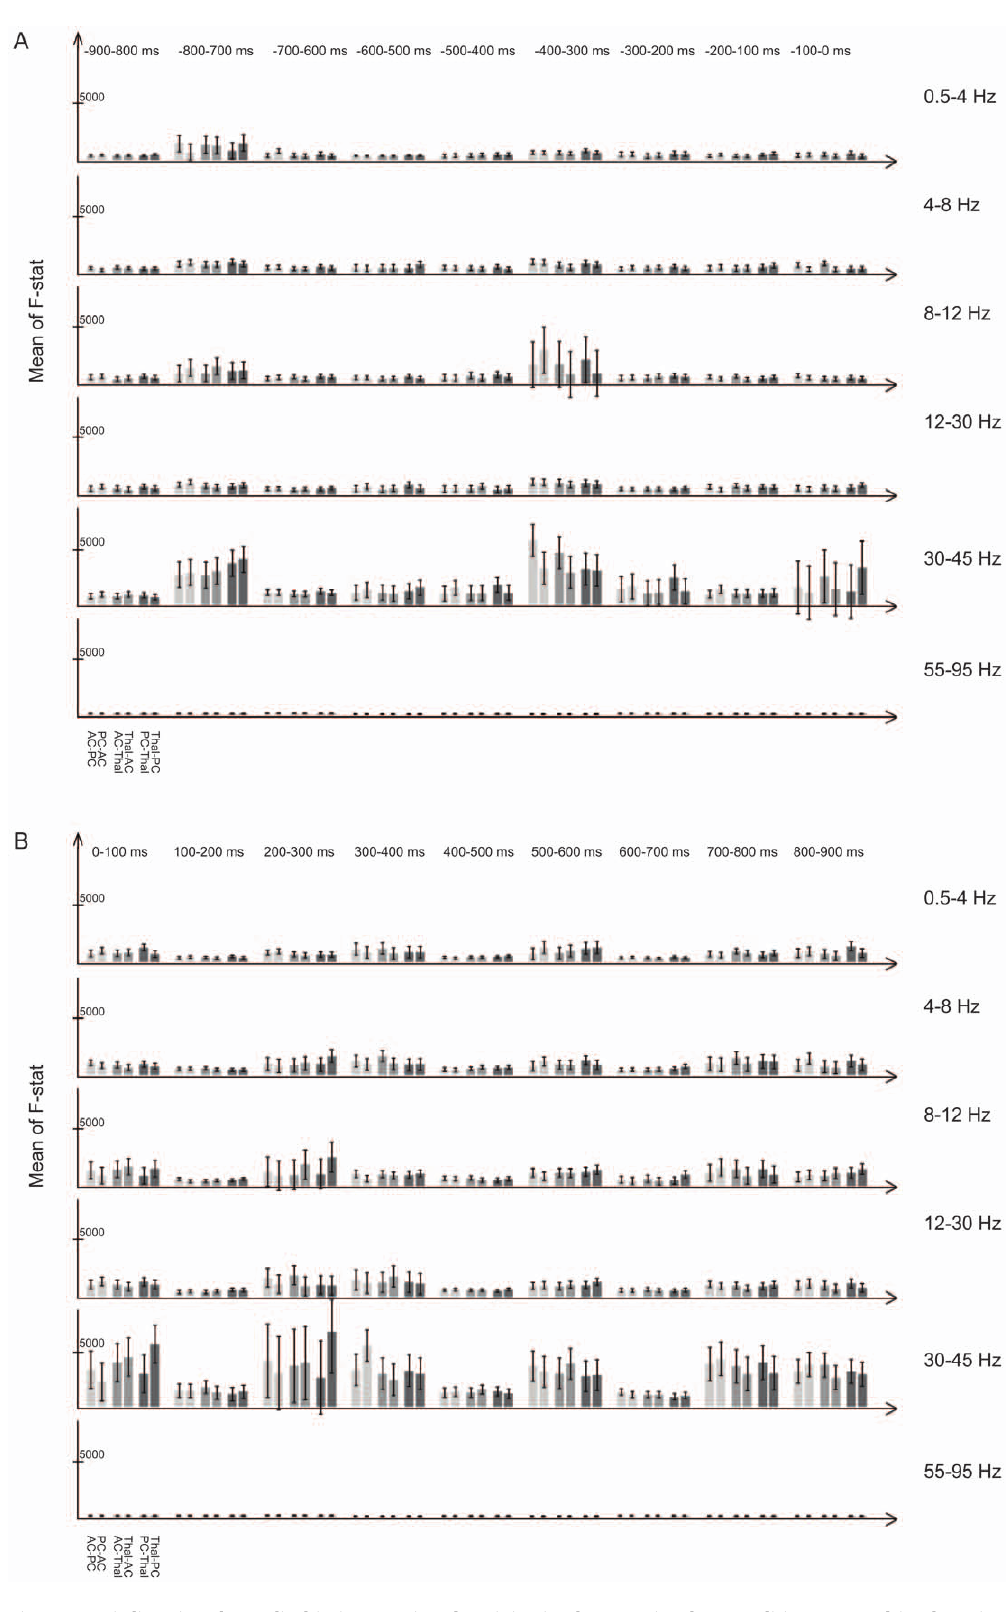
Figure 4. Bi-directional paralimbic interregional activity in the prestimulus condition (A) and in the stimulus condition (B). Granger causality is bi-directional and approximately symmetrical between regions in almost all 100 ms epochs with few exceptions, independent of frequency band, and in both conditions, although intensified in the lower gamma range and during autobiographical memory retrieval. Bars: 95% confidence limits.